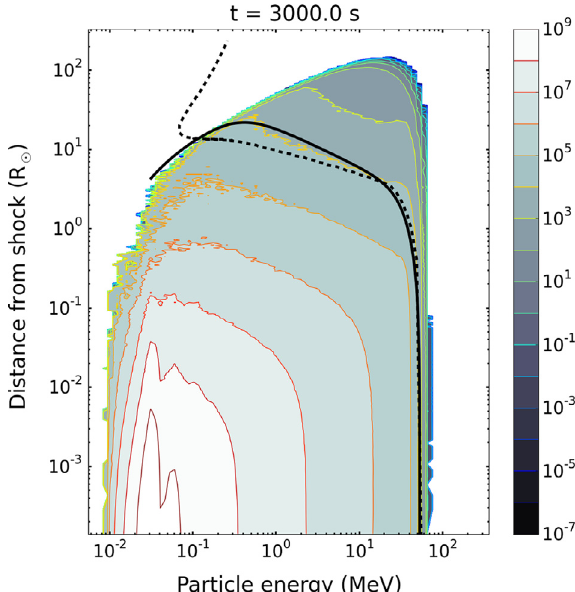
Fig. 3. An example of the fit to the foreshock boundary. The contours give the particle intensity in pfu. The dashed curve gives the foreshock boundary resulting from the simulation and the solid curve the one resulting from the semi-analytical modelling. The case considered is Run